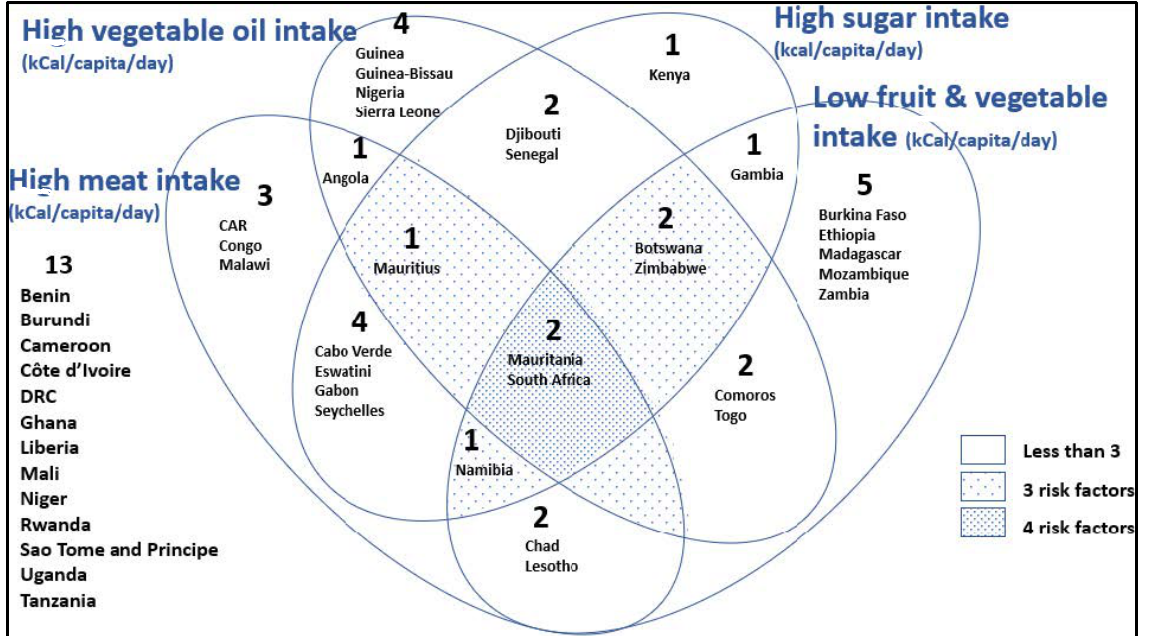
Figure 9. Venn diagram illustrating the nutrition transition in SSA countries. Those in highest tertile for meat, oil, and sugar intakes count as one risk factor each, while those with the lowest tertile for fruit and vegetables count as one. (only those in the top tertile are in the Venn circles of the diagram, i.e., 13 are not).